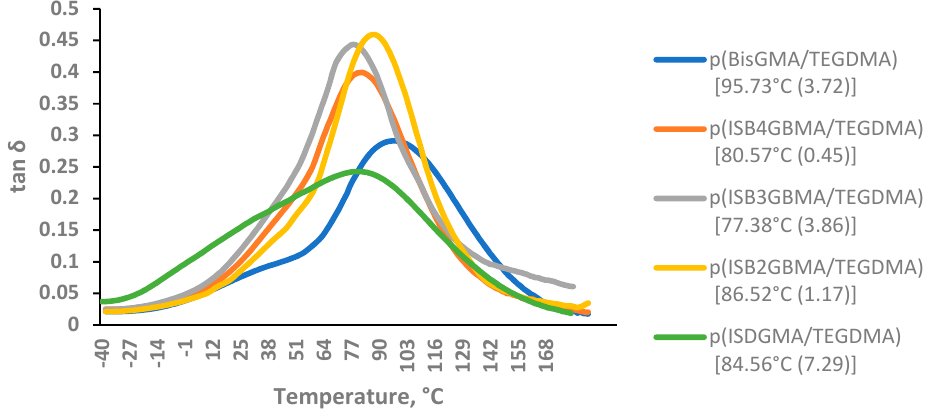
Figure 9. Tan delta of p(BisGMA/TEGDMA), p(ISB4GBMA/TEGDMA), p(ISB3GBMA/TEGDMA), p(ISB2GBMA/TEGDMA), and p(ISDGMA/TEGDMA) at 60:40 wt%. Maximum tan delta value in brackets and standard deviation in parenthesis.